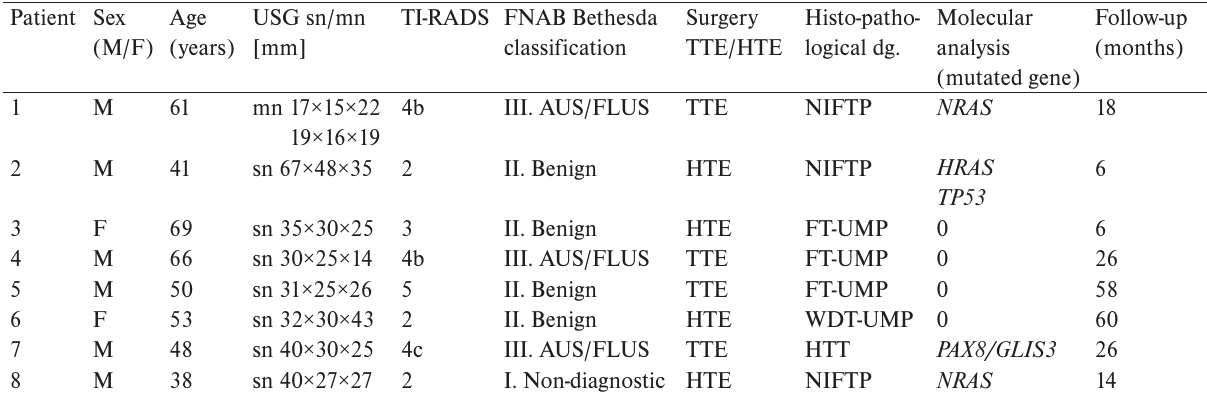
Table 1. Overview of patients, procedures and examination